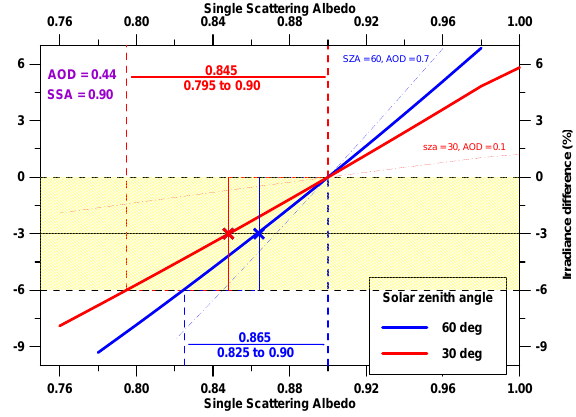
Figure 3. Retrieval GSI methodology for calculating effective SSA Fig. 3. Retrieval GSI methodology for calculating effective SSA.